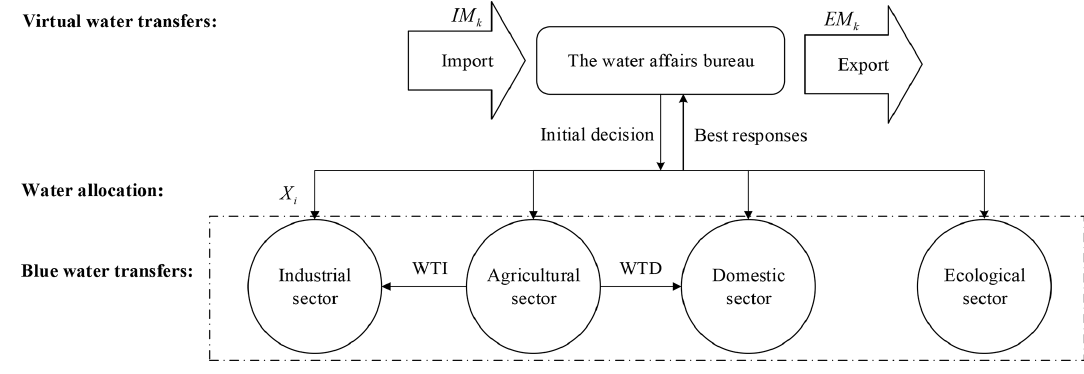
Figure 3. Bilevel water allocation system